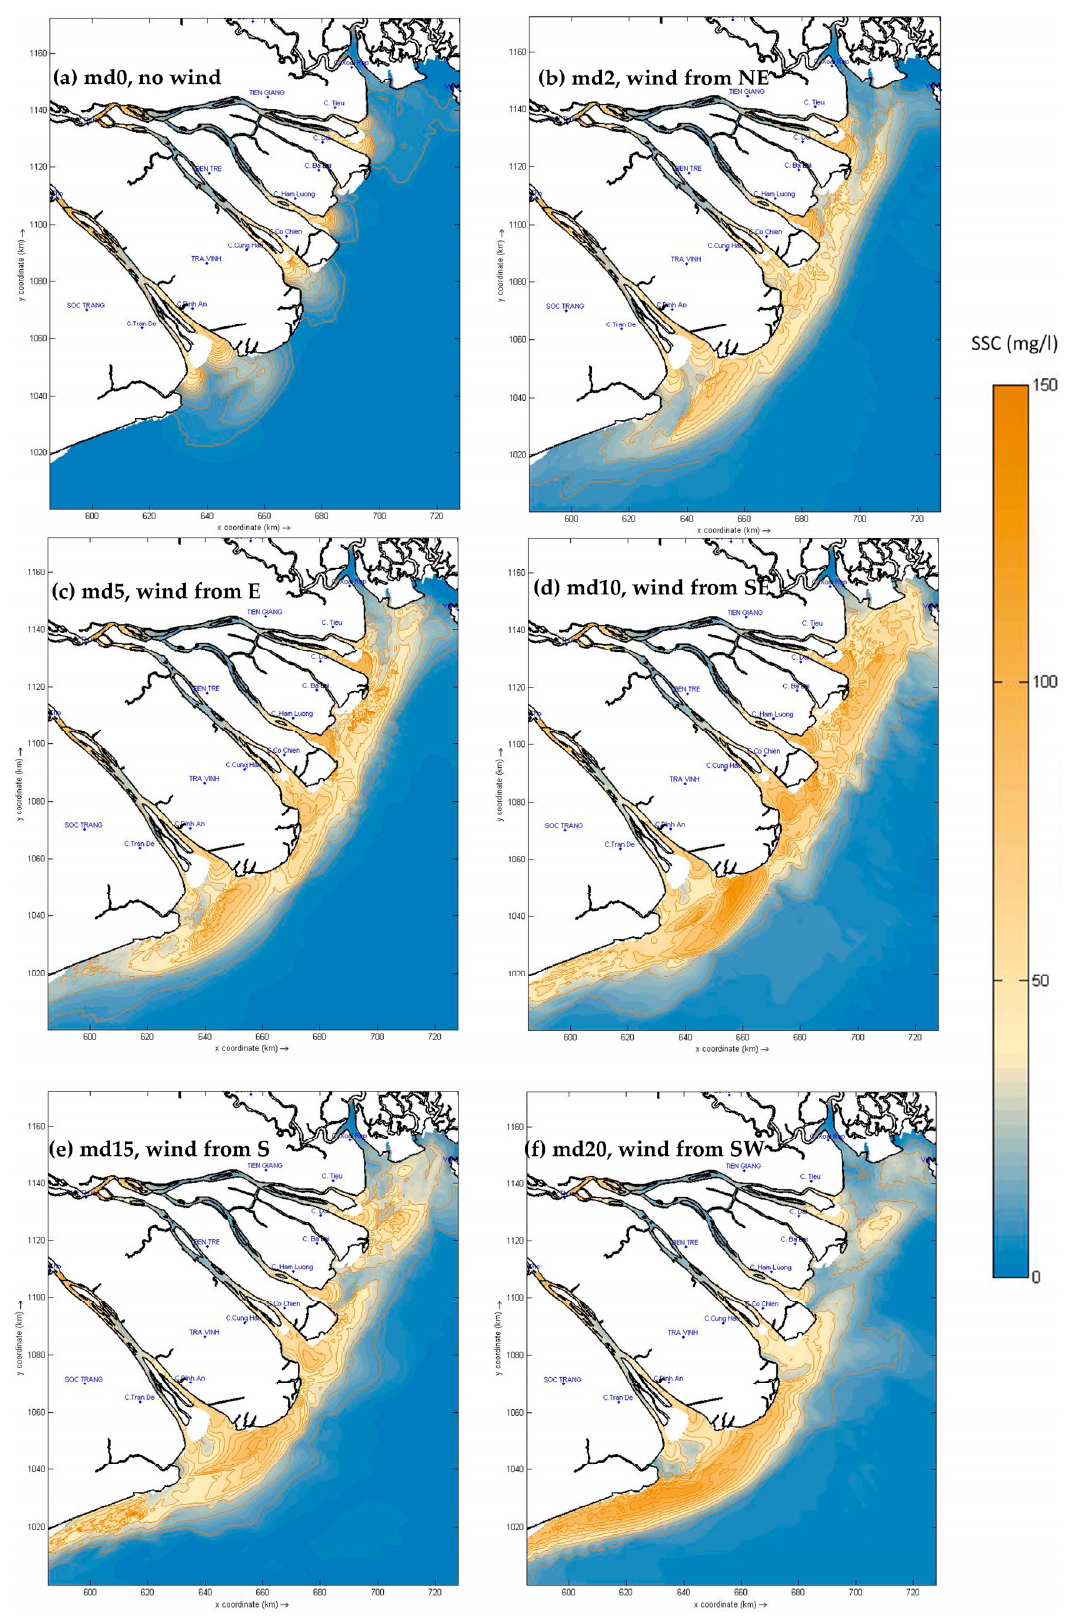
Figure 3. Distribution of suspended sediment concentration in the surface layer in the low flow season in the MRD coastal area (1 h before low tide), with no wave or wave heights = 2 m from different directions.